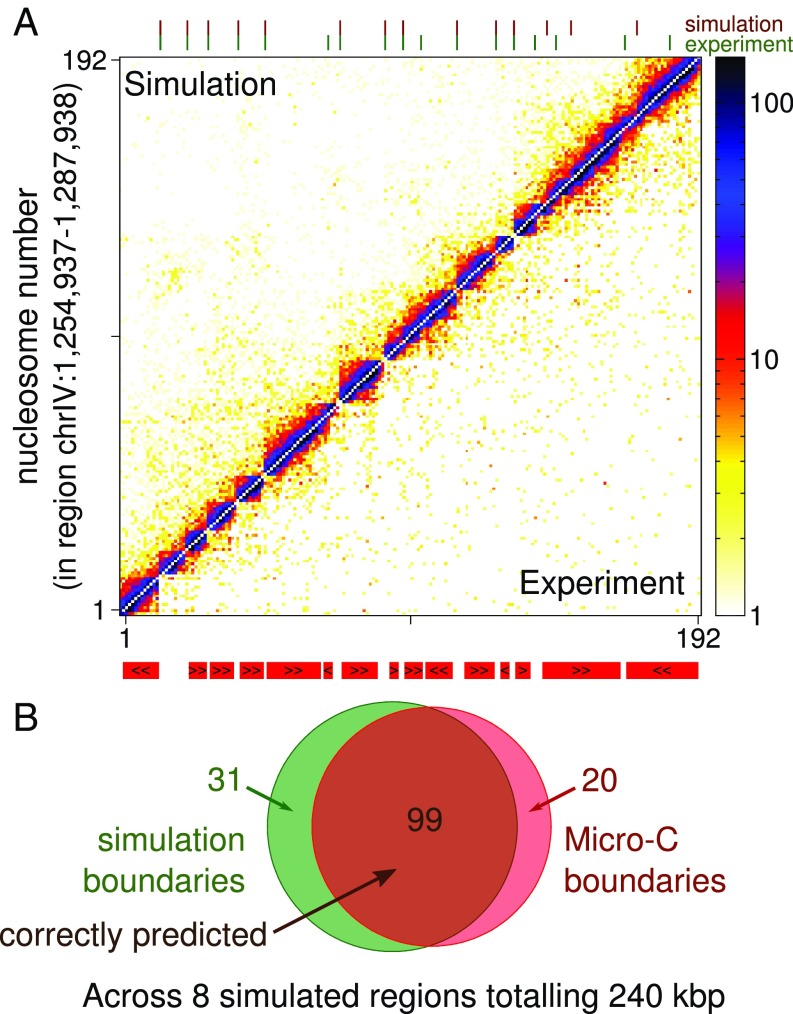
Chromatin fiber simulations accurately predict MicroC interactions for S. cerevisiae. (A) Map showing interactions between nucleosomes in region chrIV:1254937–1287938. Nucleosomes within the region are numbered starting from 1. The color of the square at coordinates i,j indicates the number of MicroC reads corresponding to interactions between nucleosomes i and j. Lower triangle shows MicroC data from ref. 11, while Upper triangle shows simulation results. The locations of genes (mapped to the nearest nucleosomes) are shown below the plot (red bars; gene orientation is indicated with black arrowheads). Domain boundaries were called from each map (see SI Appendix for details), and these are indicated with tick marks above the plot (upper row shows simulation boundaries in red, and lower row shows experimental boundaries in green). Similar plots for all 8 simulated regions are shown in SI Appendix, Fig. S4, with the MNase data used as input in SI Appendix, Fig. S1. A comparison between simulations and MicroC XL data is shown in SI Appendix, Fig. S9. (B) Venn diagram showing the number of domain boundaries across all 8 simulated regions. Overall ∼83.2% of boundaries were correctly predicted by the simulations; an additional 30 boundaries not present in the data were found in the simulated interaction maps. A “correct prediction” is defined as a boundary in the simulated map being within 1 nucleosome of a boundary in the experimental map.